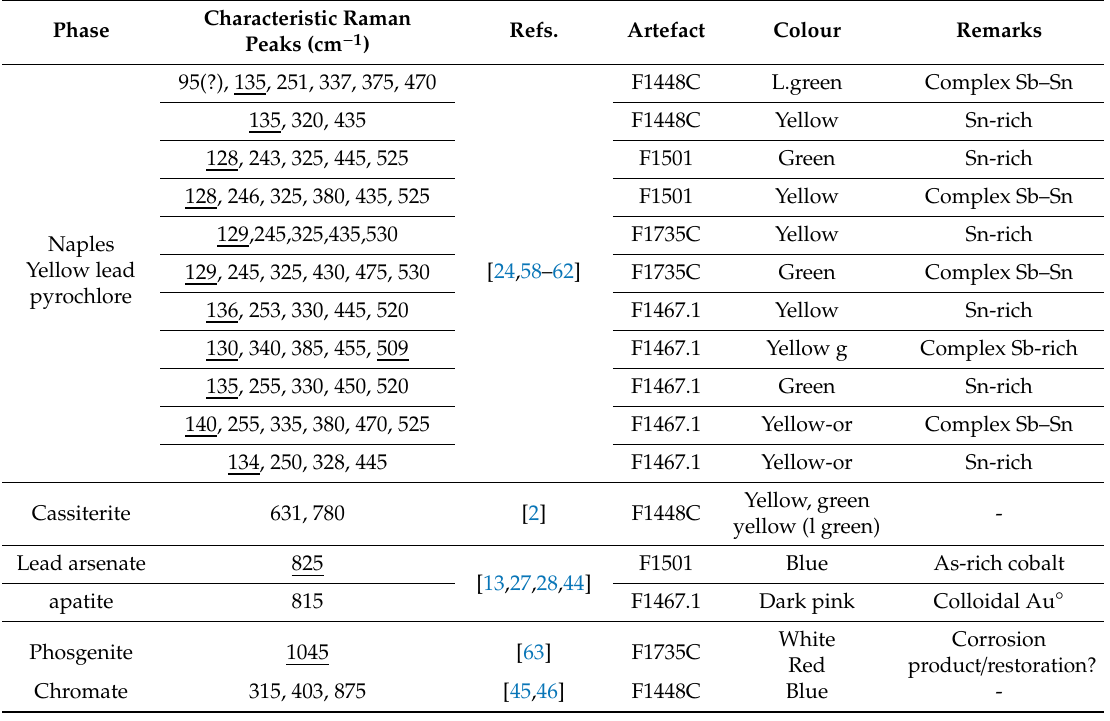
Table 2. Crystalline phases identified in the cloisonn é enamels (strongest; shoulder; L / l: light